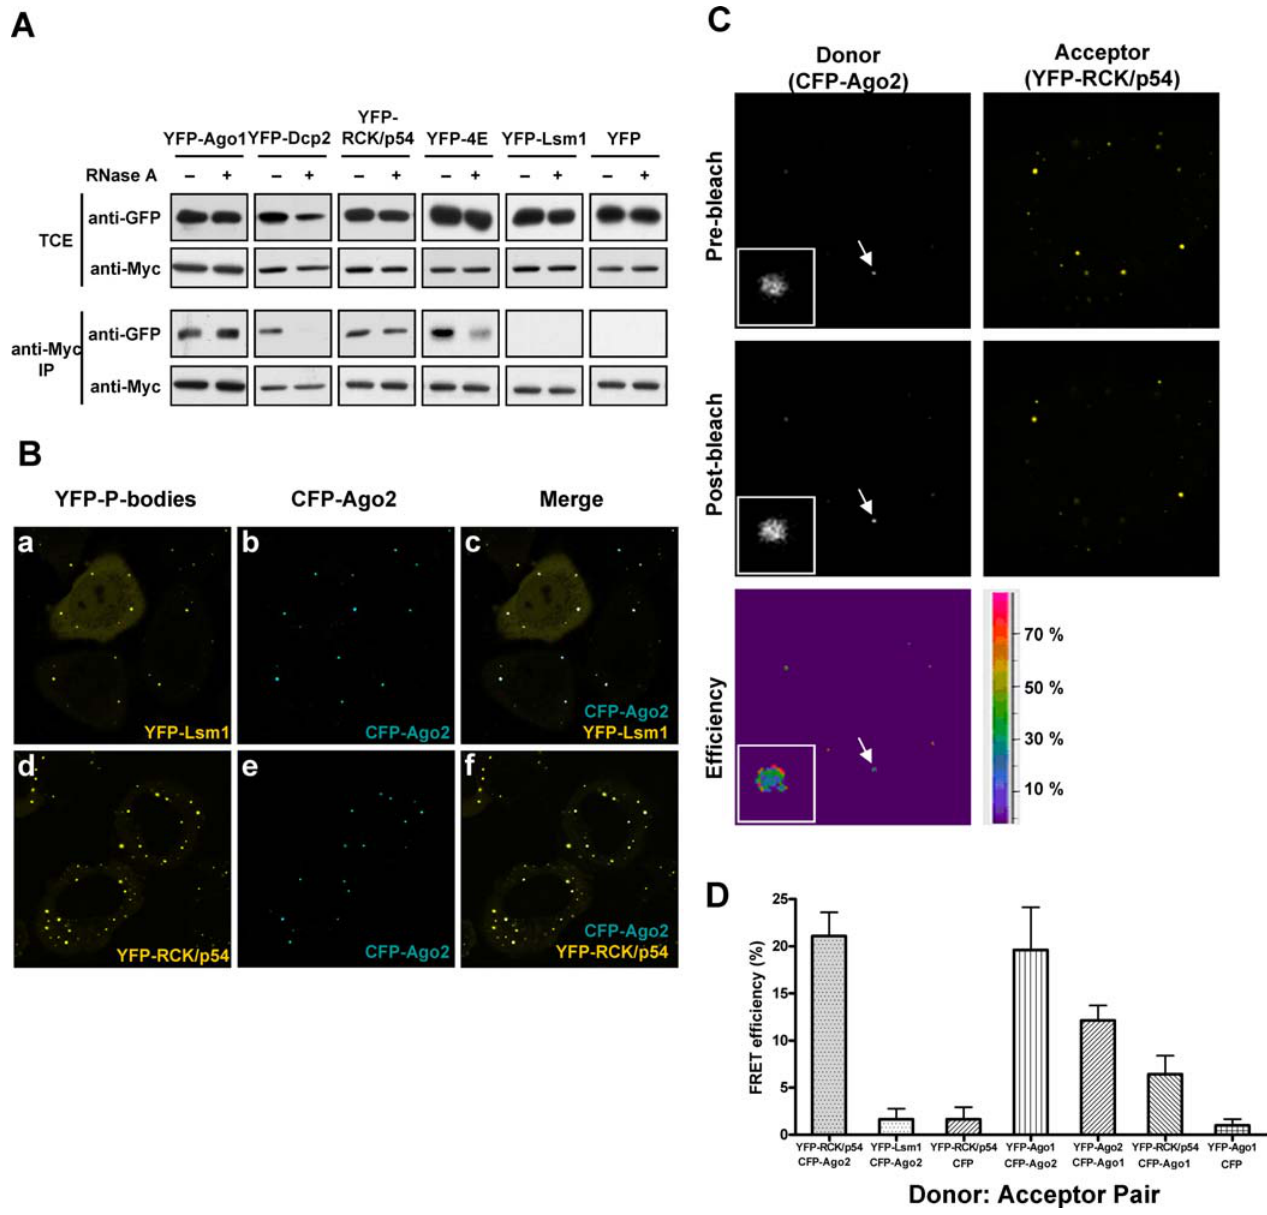
Figure 1. Human Argonaute Proteins Interact with RCK/p54, a Component of P-Bodies (A) Immunoprecipitation and immunoblot analyses. TCEs from HeLa cells co-expressing Myc-Ago2 and YFP-Ago1, YFP-Dcp2, YFP-RCK/p54, YFP-eIF4E, YFP-Lsm1, or YFP were treated with þ / (cid:1) RNase A followed by Myc-Ago2 immunoprecipitation. TCE and anti-Myc IPs were analyzed by immunoblot using anti-GFP and anti-Myc antibodies. (B) In vivo localization of RCK/p54 and Ago2 to P-bodies. HeLa cells expressing YFP-Lsm1 and CFP-Ago2 (a, b, and c), YFP-RCK/p54 and CFP-Ago2 (d, e, and f) were visualized by confocal microscopy at 24 h post-transfection. (C) Visualization of interactions between RCK/p54 and Ago2 in P-bodies by FRET. HeLa cells expressing YFP-RCK/p54 and CFP-Ago2 were fixed at 24 h post-transfection. FRET was measured by an acceptor photobleaching method. Fluorescence images of donor (CFP-Ago2) and acceptor (YFP-RCK/p54) molecules were taken before and after photobleaching YFP. FRET efficiencies were calculated as described [48,49,68], and data were analyzed by Leica confocal software. Arrows point to P-bodies, which are enlarged in insets. (D) FRET efficiencies between different P-body protein donor: acceptor pairs. HeLa cells co-expressing YFP-RCK/p54 and CFP-Ago2, YFP-Lsm1 and CFP- Ago2, YFP-RCK/p54 and CFP, YFP-Ago1 and CFP-Ago2, YFP-Ago2 and CFP-Ago1, YFP-RCK/p54 and CFP-Ago-1, as well as YFP-Ago1 and CFP, were fixed and FRET efficiencies were measured. DOI: 10.1371/journal.pbio.0040210.g001